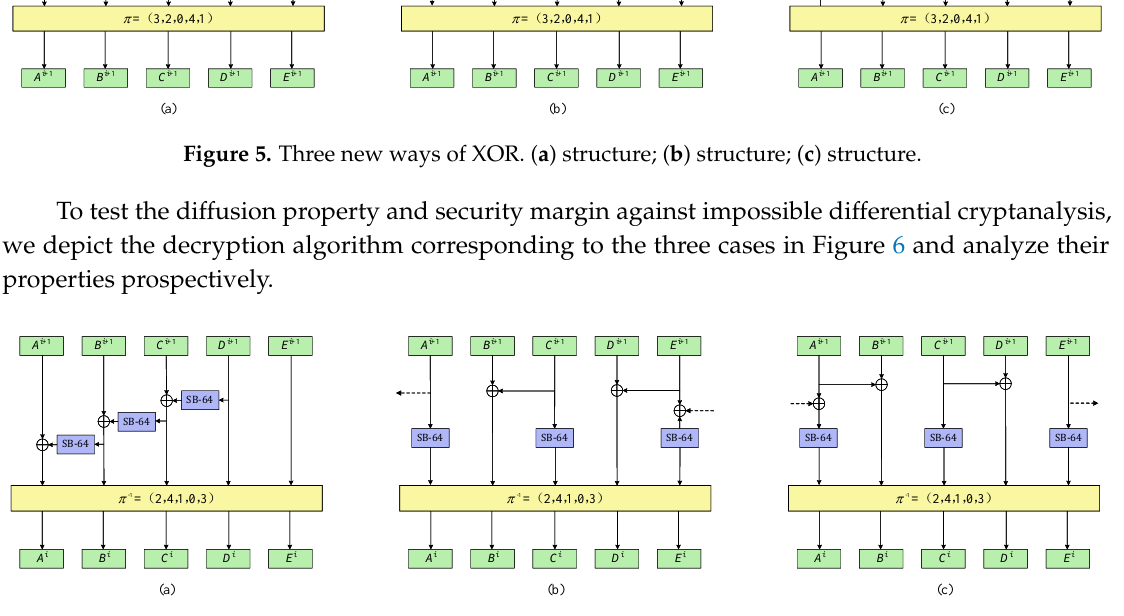
Figure 6. The inverse structure of three new ways of XOR. ( a ) structure; ( b ) structure; ( c )